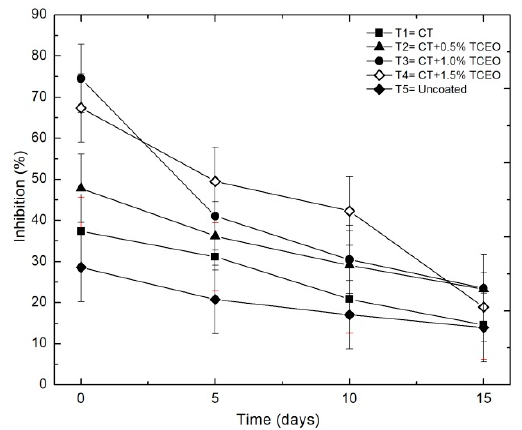
Figure 12. Evolution of the antioxidant capacity by the ABTS method in strawberries with chitosan (CT) and treatments of oil (TCEO): T1 = CT, T2 = CT + 0.5% of TCEO, T3 = CT + 1.0% of TCEO, T4 = CT + 1.5% TCEO, and T5 = uncoated throughout a 15-day period. Mean values and intervals of Fisher’s LSD of 95% according to the ANOVA test.